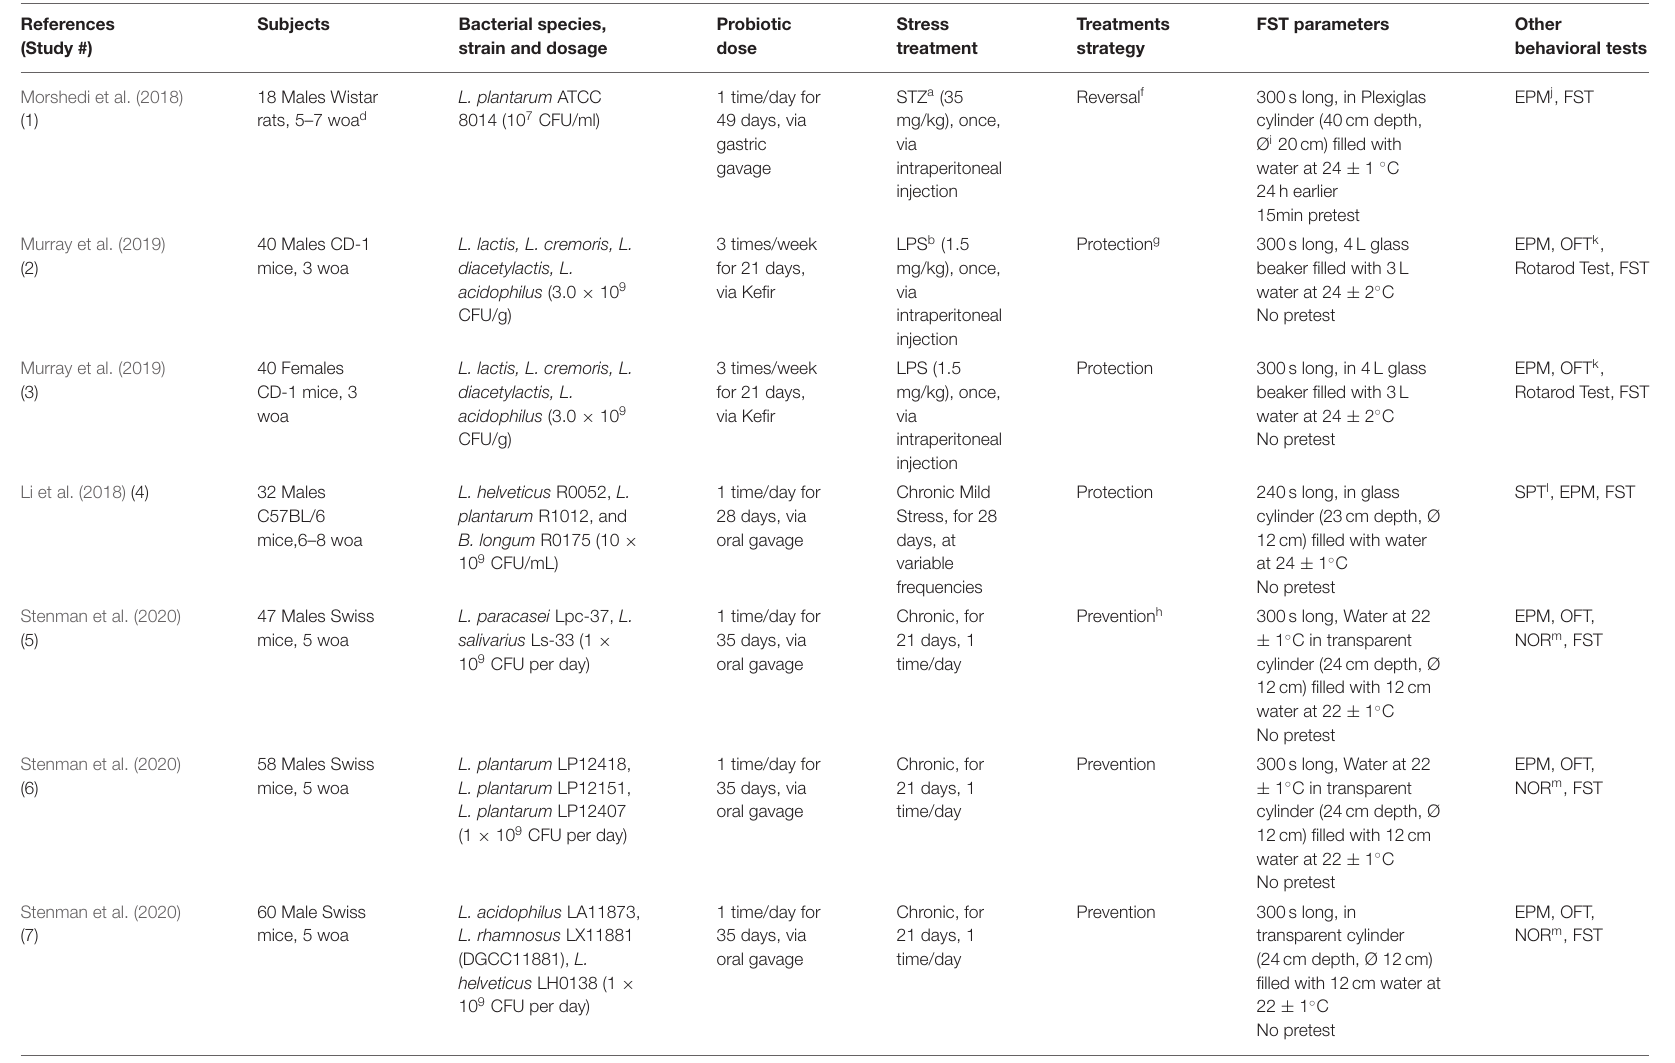
TABLE 1 | Characteristics of studies collected from the literature review search for the meta-analysis on the effect of Lactobacillus -based supplementation and stress treatments in rodents in the Forced Swim Test